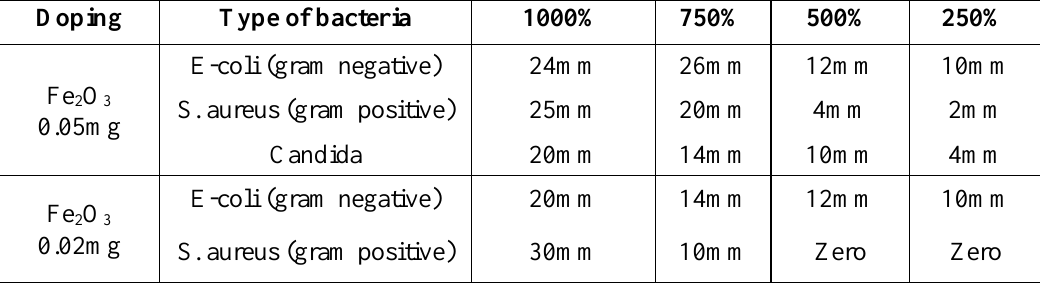
Table 2: The value of inhibition zone (gram-negative and positive).